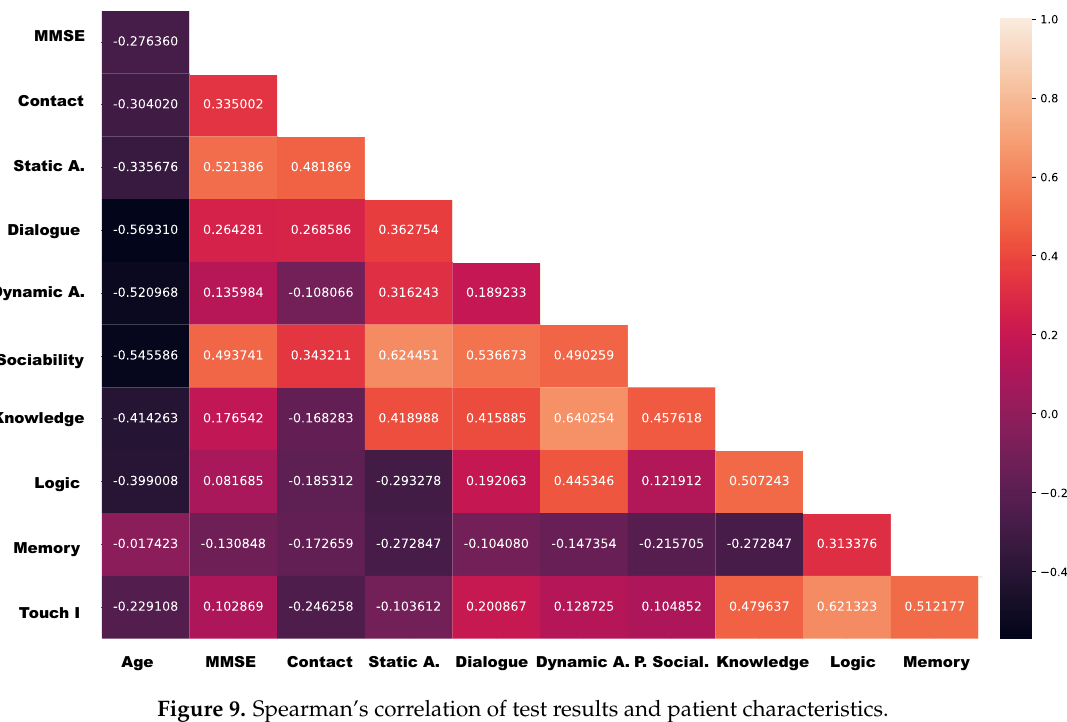
Figure 9. Spearman’s correlation of test results and patient characteristics.